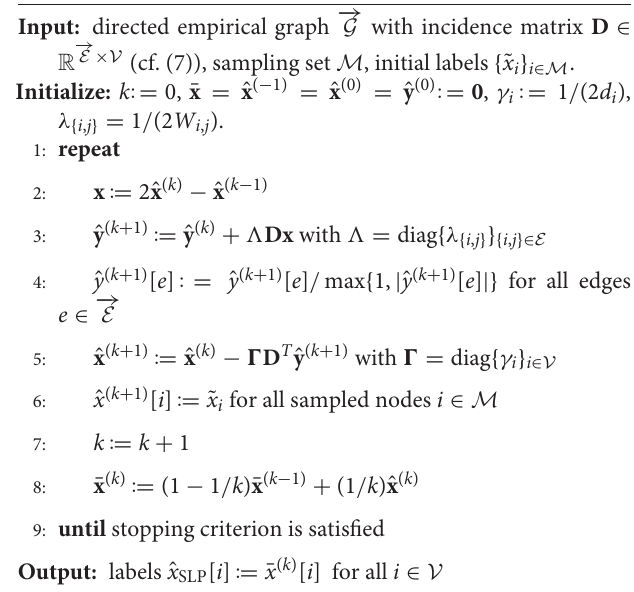
Algorithm 1 Sparse Label